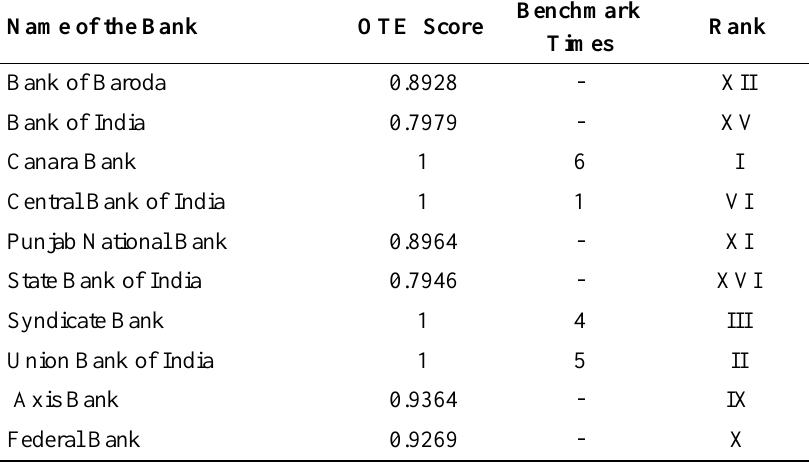
Table 5: Ranking of the Banks Name of the